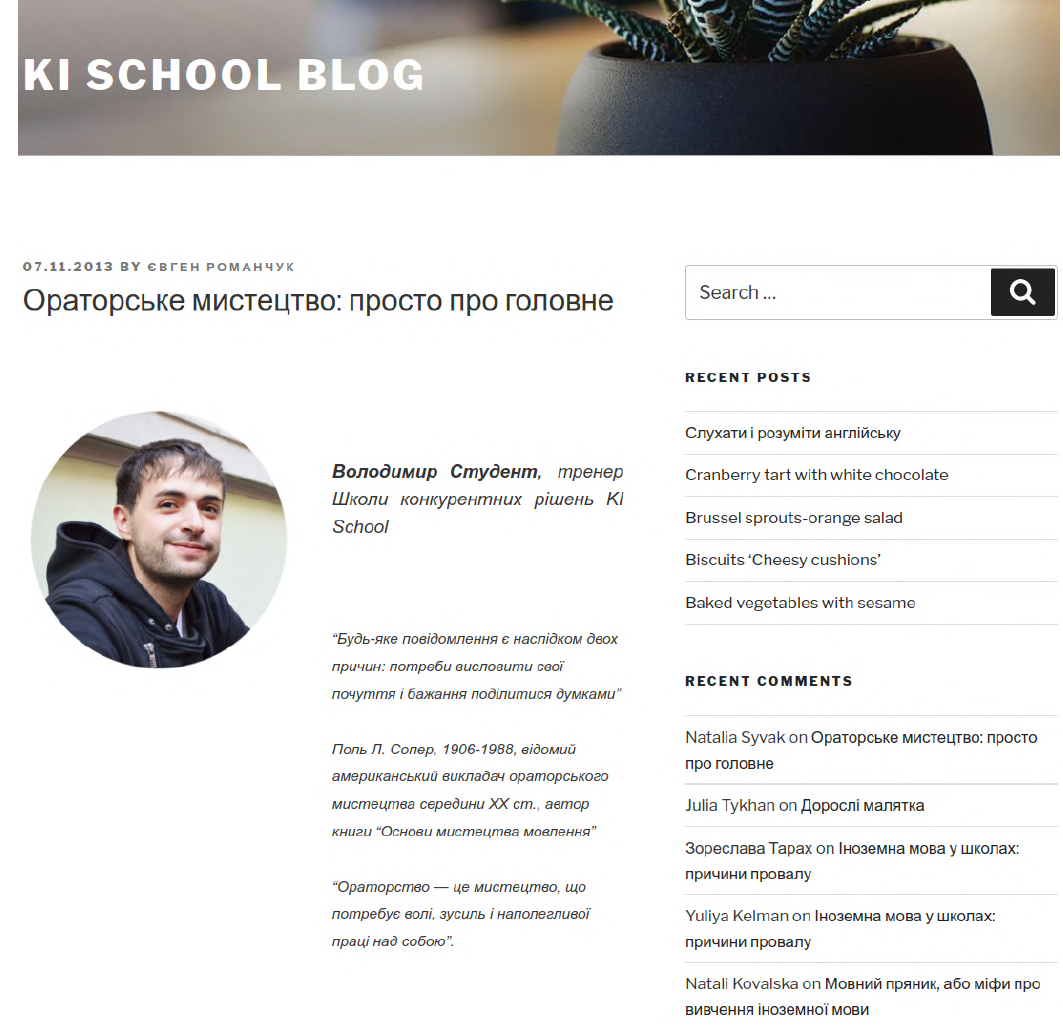
Figure 5: Blog “Oratory: just about the main